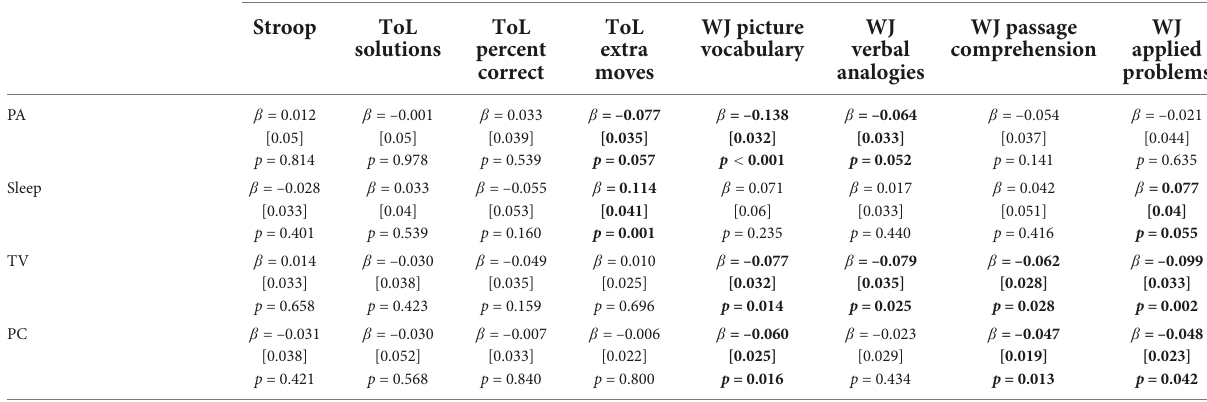
TABLE 2 Standardized predictive effects for primary